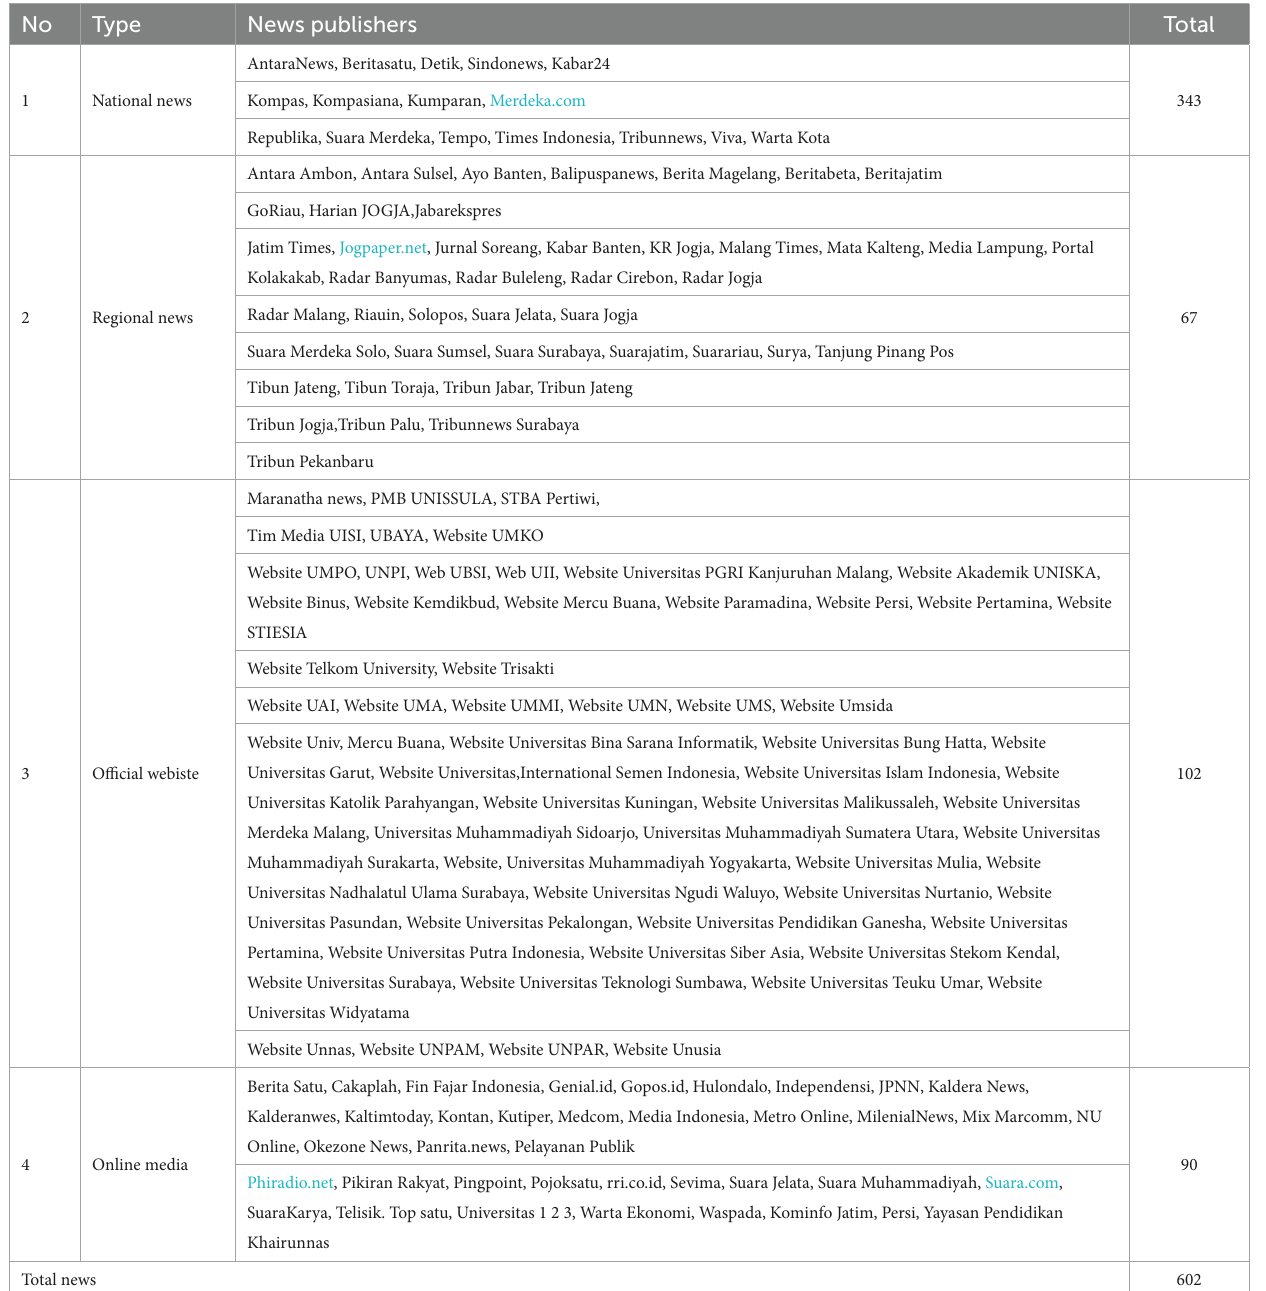
TABLE 3 Number and source of news